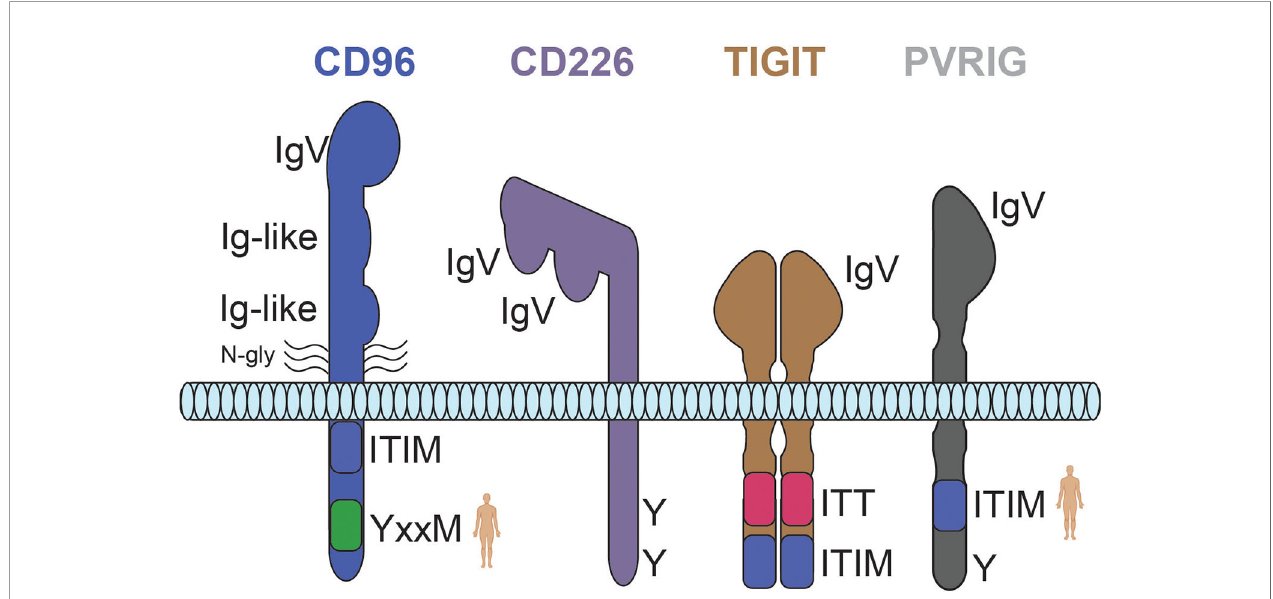
FIGURE 2 | Predicted structures for the CD226 axis receptors CD96, CD226, TIGIT, and PVRIG. The weight of each line is representative of the relative strength of interaction. Human silhouettes signify that a motif is not present in rodents. N-gly, n-linked glycosylation; Y, tyrosine residue; ITT, immunoglobulin tail tyrosine motif; ITIM, immunoreceptor tyrosine-based inhibition motif.